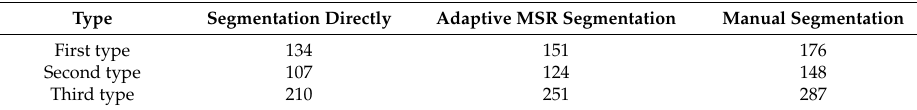
Table 3. The number of white points (bubble seeds) in three types of